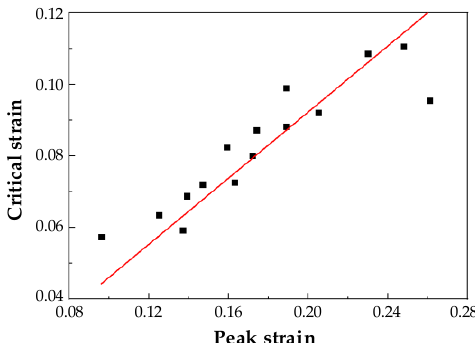
Figure 5. The relationship map of ε p and ε c under different temperatures and strain